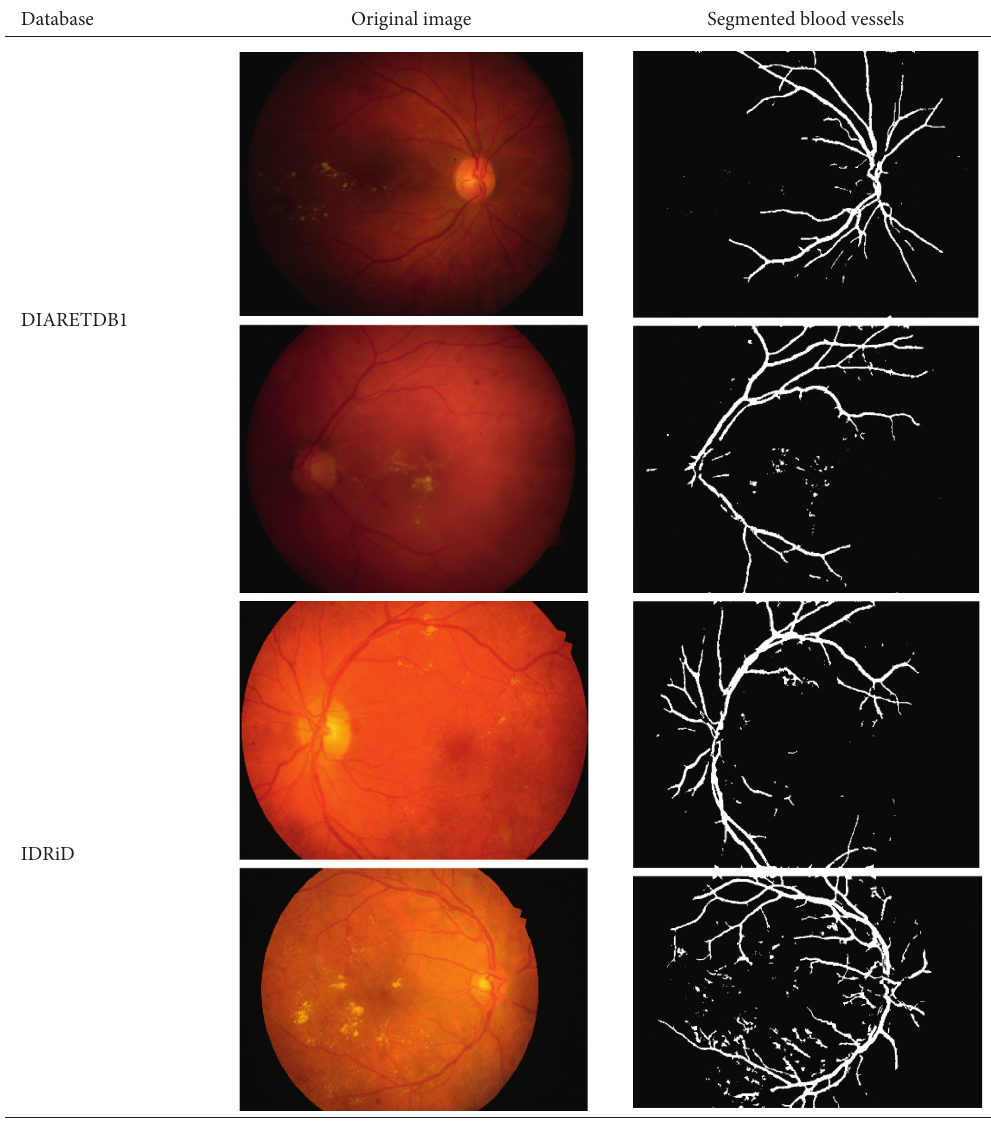
Figure 3: Segmented blood vessels from DR retinal